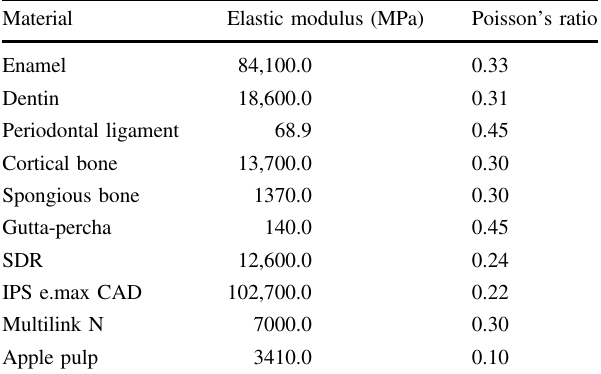
Table 1 Material properties in the FEA models [20, 30, 31]